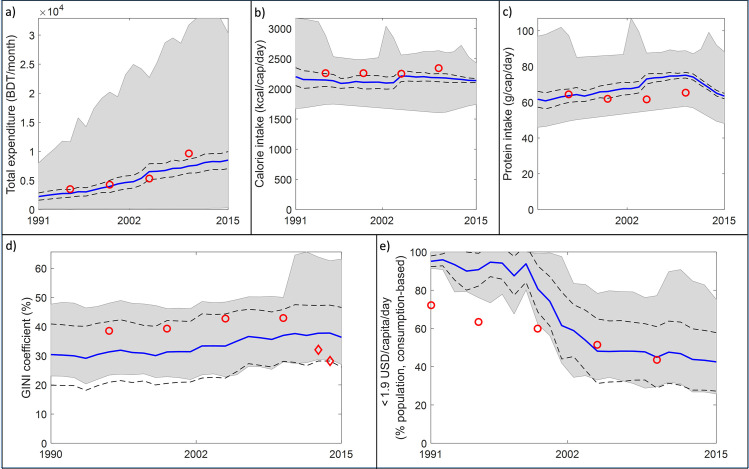
Validation plots showing (a) total expenditure, (b) calorie intake, (c) protein intake, (d) income inequality and (e) World Bank poverty indicator for coastal Bangladesh. Thick solid blue lines: simulated mean; Black dash lines: ±1.5 standard deviation (~85 percent); Shaded area: min-max simulated range; Red dots and diamonds: observations. Observations: a-c) BBS [56: Tables 4.4, 5.3, 5.4]; d) dots: rural inequality [59], diamonds: national inequality [60]; e) People living on less than US$1.90 a day [61].